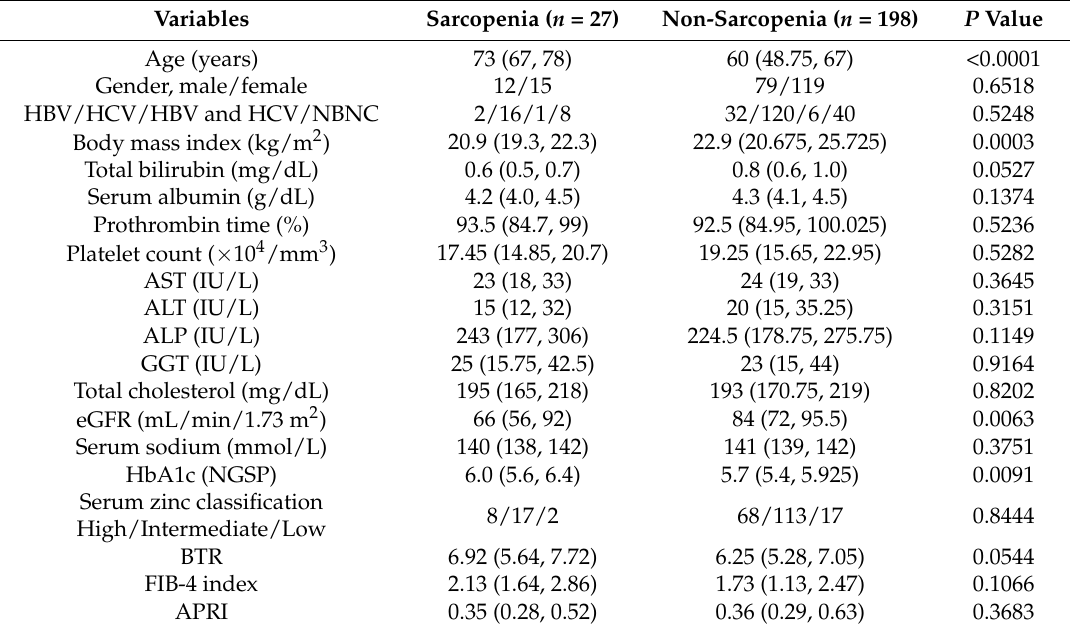
Table 6. Univariate analyses of factors associated with the presence of sarcopenia for non-LC cases ( n = 225).